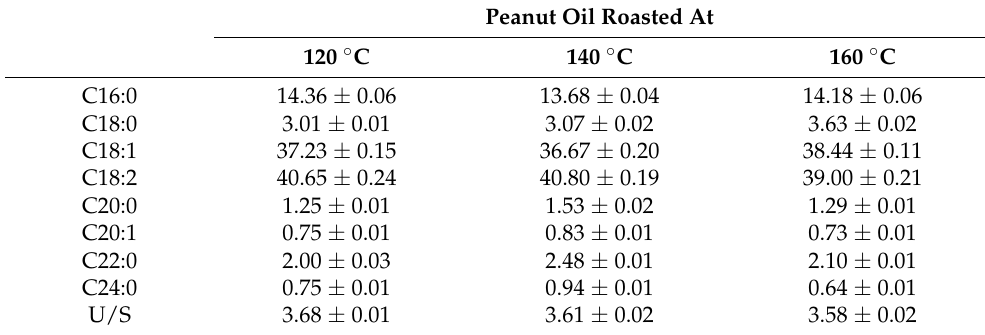
Table 2. Fatty acid compositions (%) in peanut oils was influenced by roasting